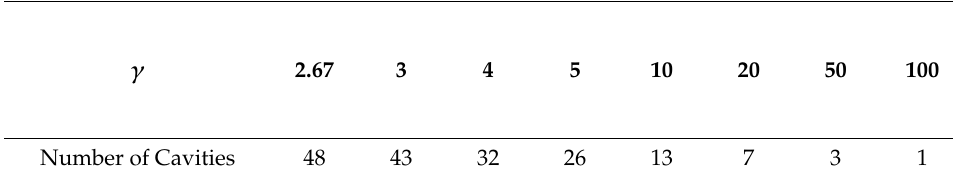
Figure 19. Variation of f/f 1 , Nu/Nu 1 and ƞ with 𝛾 for different Reynolds number. ( a ) f / f 1 , Nu / Nu 1 , ( b ) ƞ. Table 2. Values of γ and corresponding numbers of